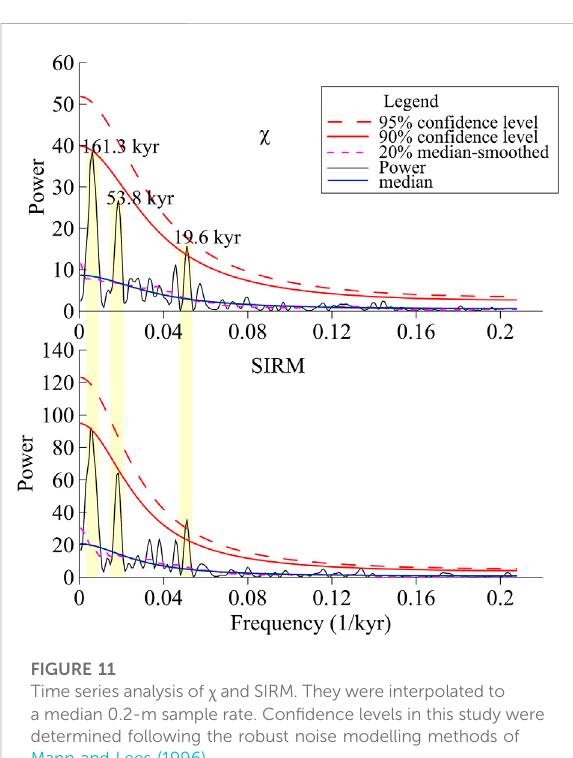
FIGURE 11 Time series analysis of χ and SIRM. They were interpolated to a median 0.2-m sample rate. Con fi dence levels in this study were determined following the robust noise modelling methods of Mann and Lees